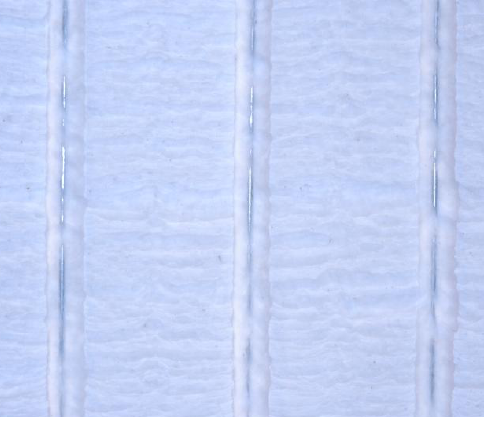
Figure 1. C lose up view of the metal wire-tires on a commercial cotton bale. For reference the ties are spaced at 17 cm between ties.